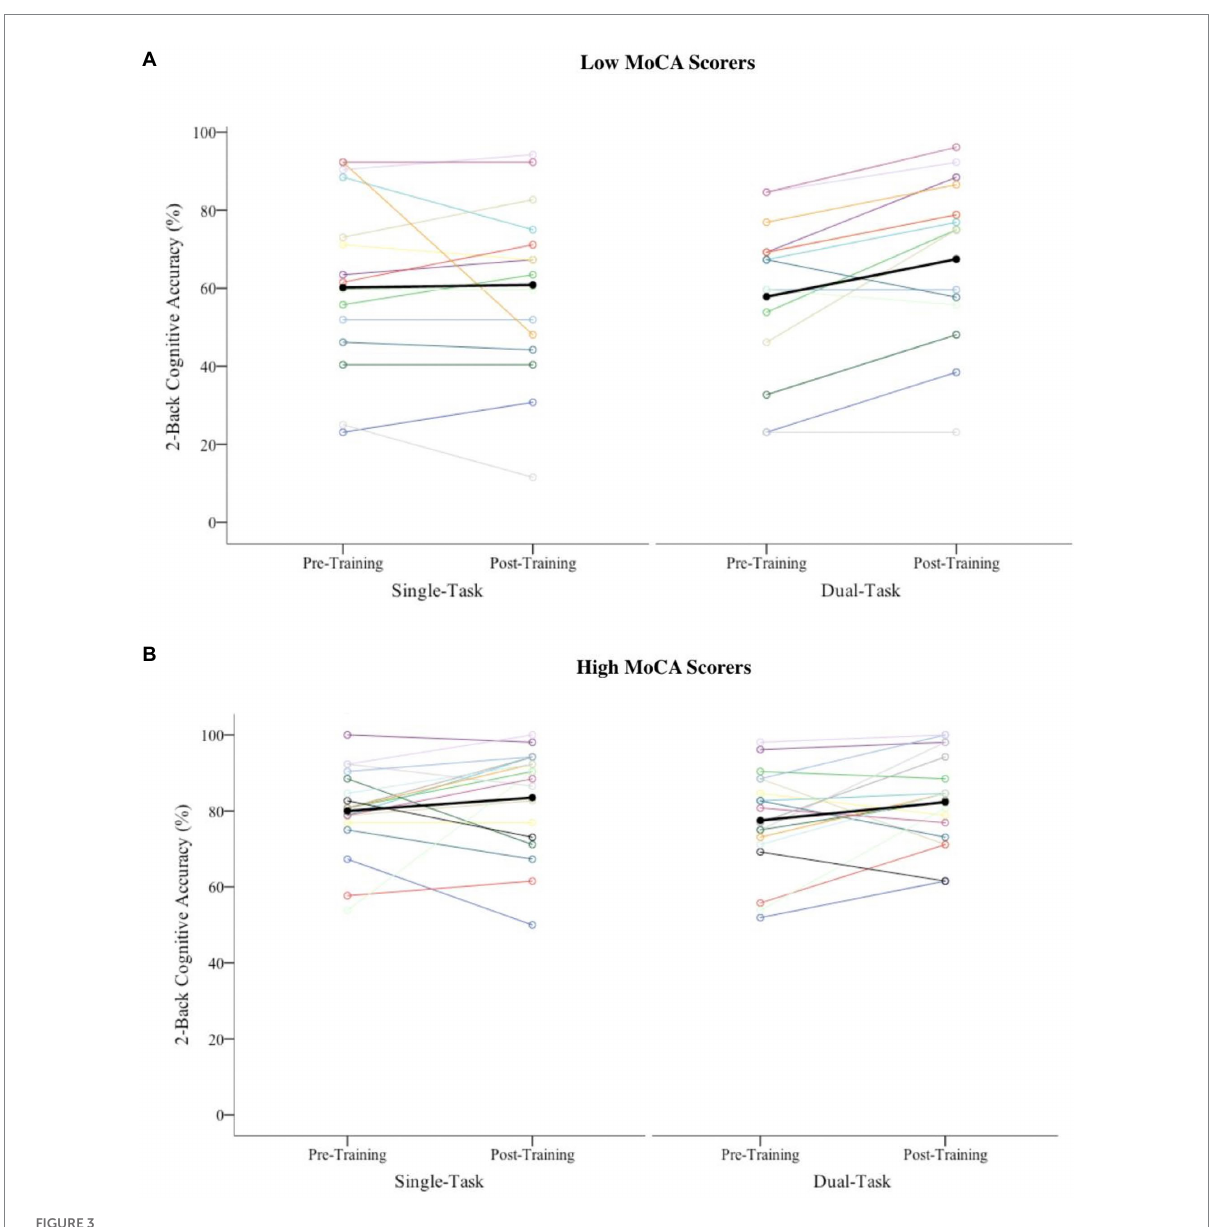
FIGURE 3 Single- and dual-task cognitive accuracy performance before and after training across participants with low versus high MoCA scores. Note: (A) Low baseline MoCA scorers (i.e., <26; n = 14), (B) high Low baseline MoCA scorers (i.e., ≥ 26; n = 18). Each line represents an induvial participant score (black line indicates the mean). While the high MoCA scores have the highest accuracy before and after training, there is greater improvement in the single to dual-task cost ration in low MoCA scores, leading to dual-task